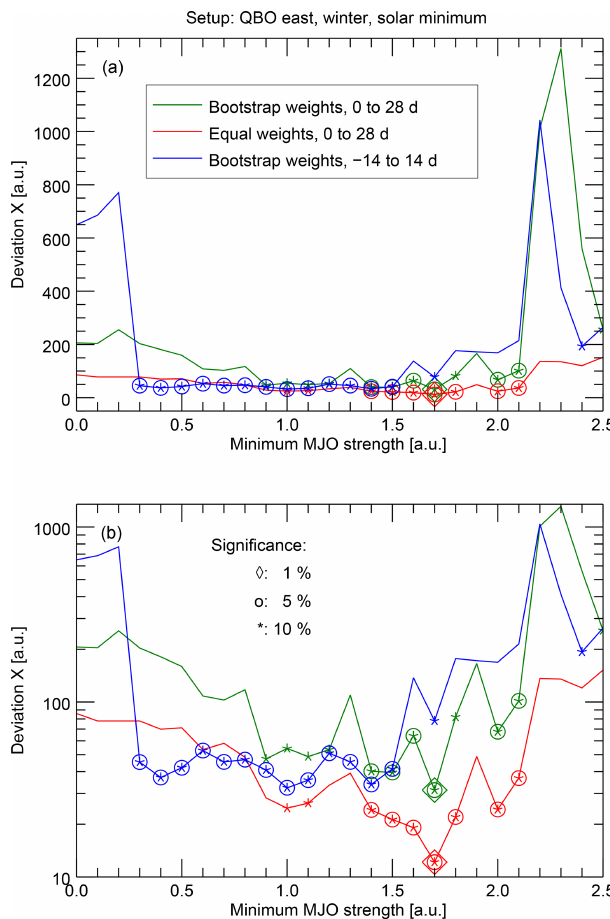
Figure 5. Calculated deviations X indicating the strength of the sta- tistical connection between the solar 27-day cycle and the MJO phase evolution; a lower X indicates a stronger connection. The same data are shown in linear scaling (a) for an overall visual im- pression and in logarithmic scaling (b) for inspection of the smaller variations. The focus of this experiment is the dependence of the de- viation on the MJO strength threshold. The green line shows these results for the standard numerical setup. Three levels of significance in the sense of the MC experiment are shown: 10%, 5%, or 1% chance of getting lower deviations with randomly modified solar extremum dates. The other two lines give an impression of the re- action of the results when the numerical setup is changed to, first, a different epoch definition (blue line) or, second, the use of constant weights (red line; see Sect. 4.2 for